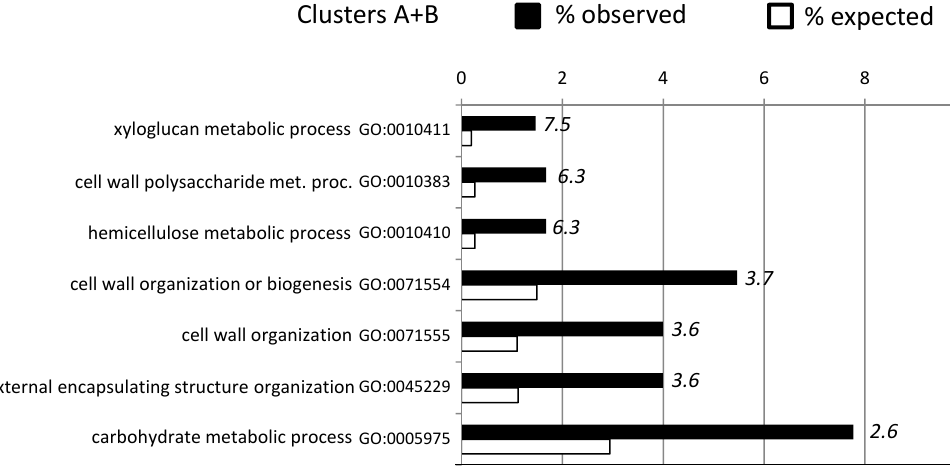
Figure 6 . GO term enrichment analysis (p < 0.05 FDR corrected) for biological processes of genes in cluster A and B (see Figure S5). For each GO term, the expected (white bars) and the observed (black bars) percentage is presented. Numbers in italics indicate the fold enrichment. Only GO-terms with more than 2-fold enrichment are shown.